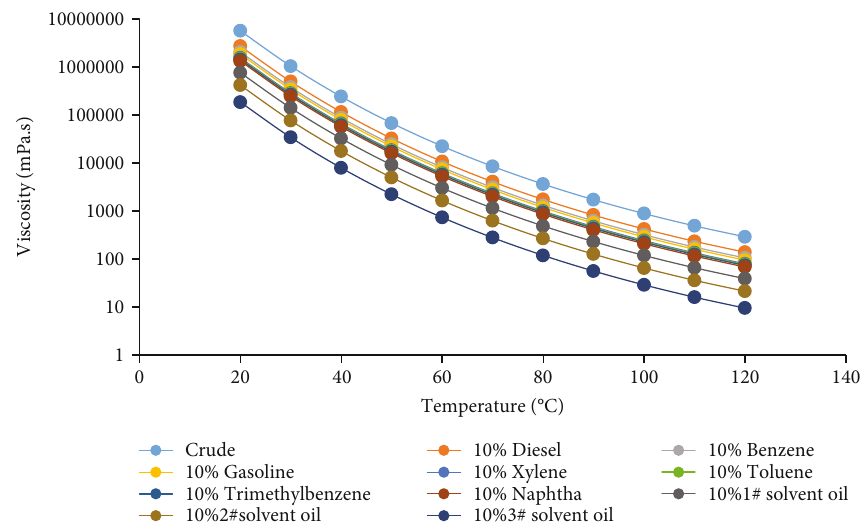
Figure 1: Experiment of dissolving asphalt with di ff erent solvents (50 ° C).